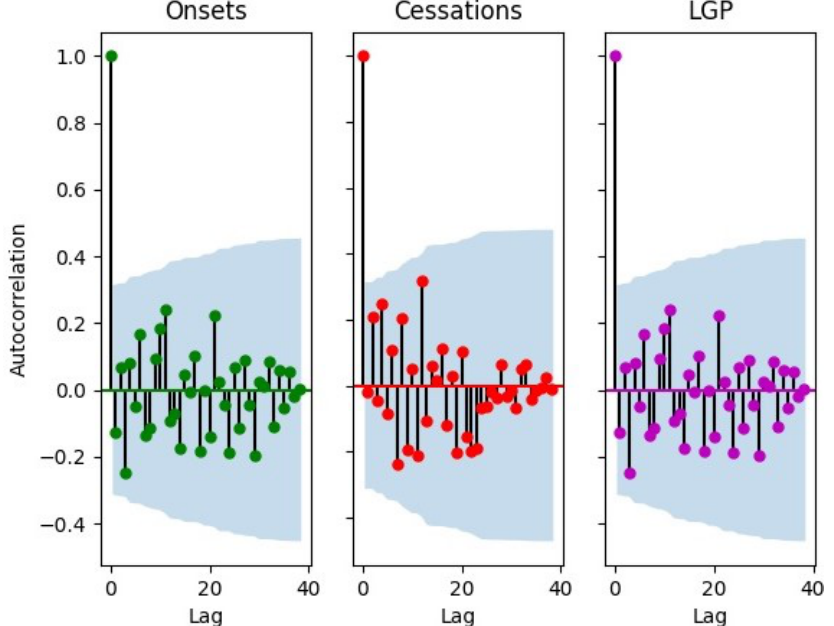
Figure A2. Autocorrelation function of rainfall onset (green), cessation (red) and length of growing season (magenta) over Northern Ghana. The blue shaded region is the confidence interval with a value of α = 0.05. Anything within this range represents a value that has no significant correlation which implies no serial